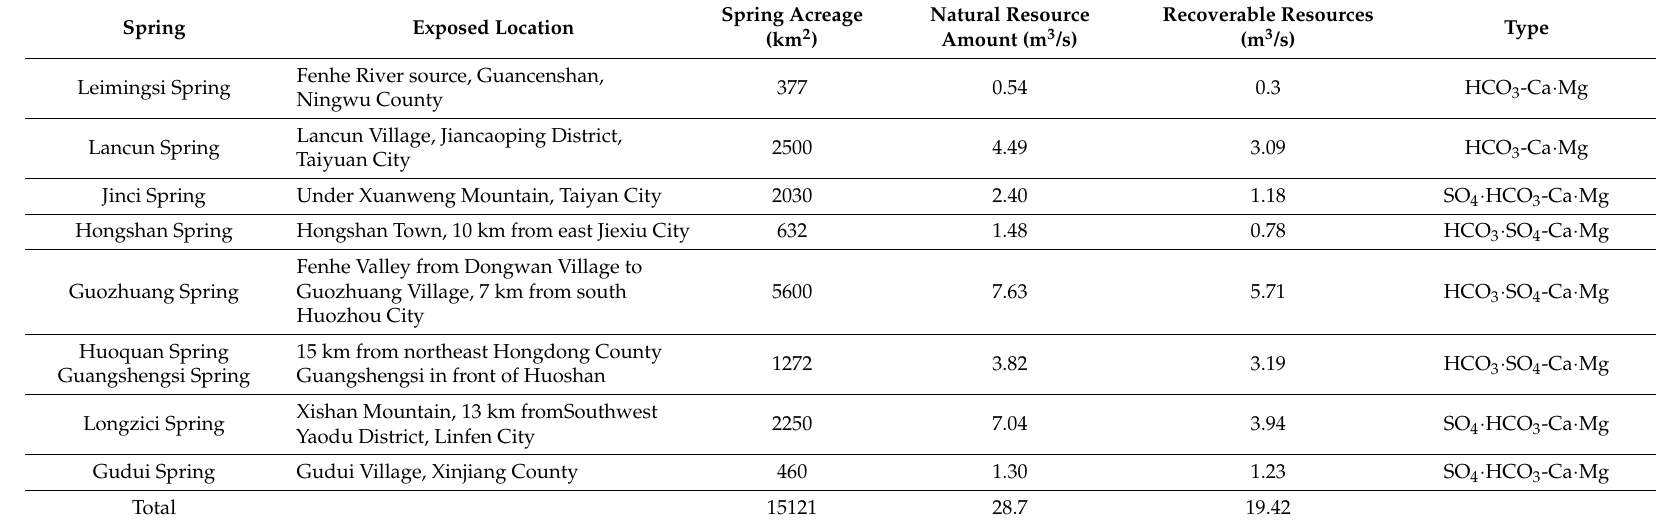
Table 11. Basic information on karst springs in the Fenhe River